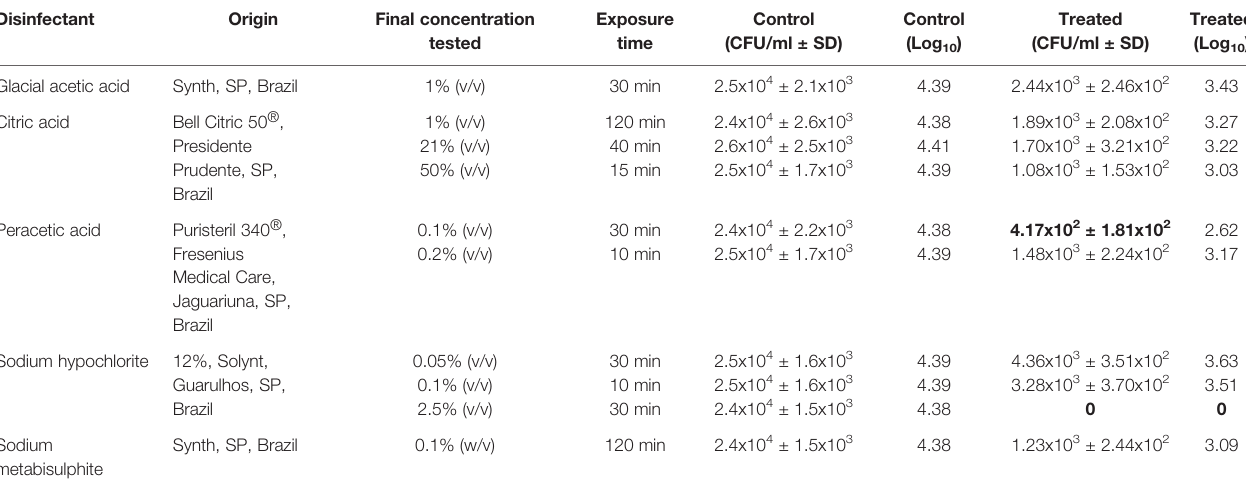
Figure 3 . ALT liver enzyme had higher-level values than the other groups (p ≤ 0.05), denoting liver injury. The hematological values determined for the animal groups are shown in Figure 4 . The comparison between the CT and SS group or DSF was performed using the Student t-test. There was a signi fi cant difference between the RBC (p<0.05) and HCT (p <0.05) values